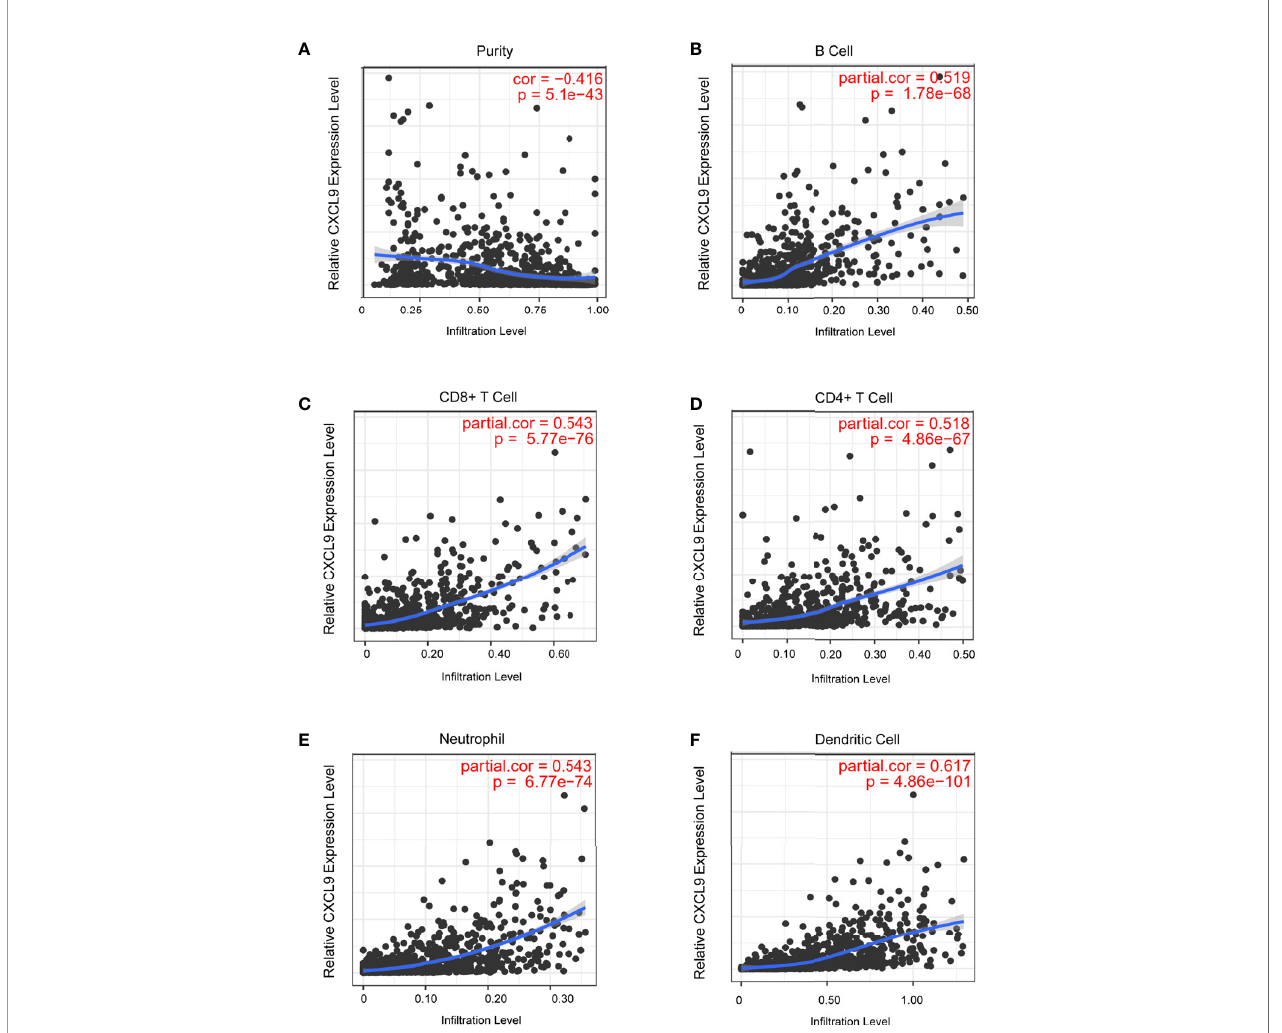
FIGURE 5 | Correlation analysis of CXCL9 expression and in fi ltration levels of immune cells in BRCA tissues using the TIMER database. (A – F) CXCL9 expression in BRCA tissues positively correlates with tumor purity (A) and in fi ltration levels of B cell (B) , CD8+ T cell (C) , CD4+ T cell (D) , neutrophil (E) , and dendritic cell (F)